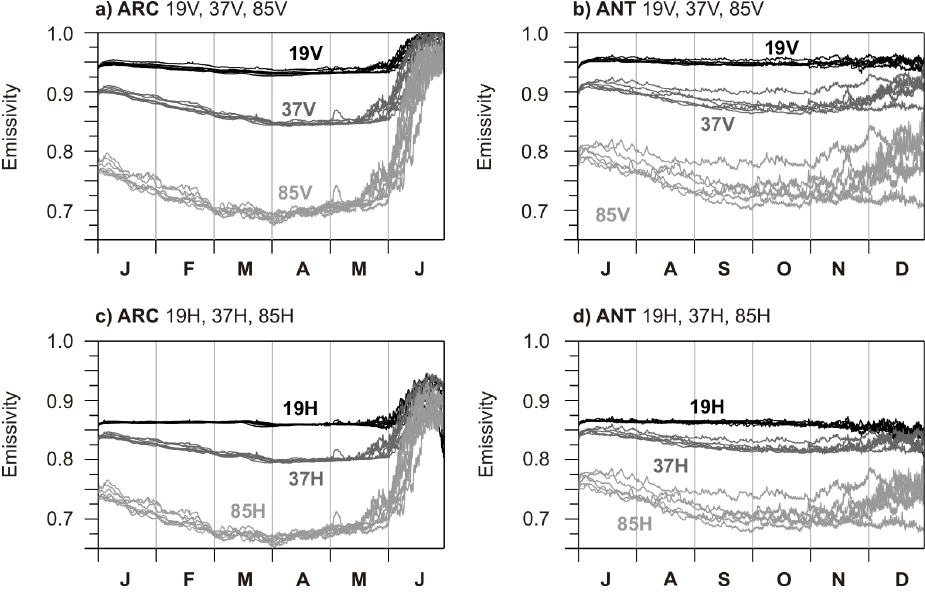
Fig. 4. The seasonal evolution of simulated 19GHz, 37GHz and 85GHz emissivities at vertical (a, b) and horizontal (c, d) polarizations for Arctic regions ( a , c , January to June) and Antarctic regions ( b , d , July to December). Data are averaged for the period from 2000–2009. Table 1. Mean and standard deviation of emissivities at 19, 37 and 85GHz (vertical polarization) for different SNTHERM initialization and MEMLS parameterization for region WW during October, derived from 4-times daily values, 2000–2009. REF: initialization profile used within this study, zs15: 15cm snow depth, zs50: 50cm snow depth, dg15: 1.5mm grain size, S02: sea-ice salinity 2ppt, S12: sea-ice salinity 12ppt, D270: snow density 270kgm − 3 , D370: snow density 370kgm − 3 , lay1: an ice layer with 910kgm − 3 density is included in the middle of the profile right from the